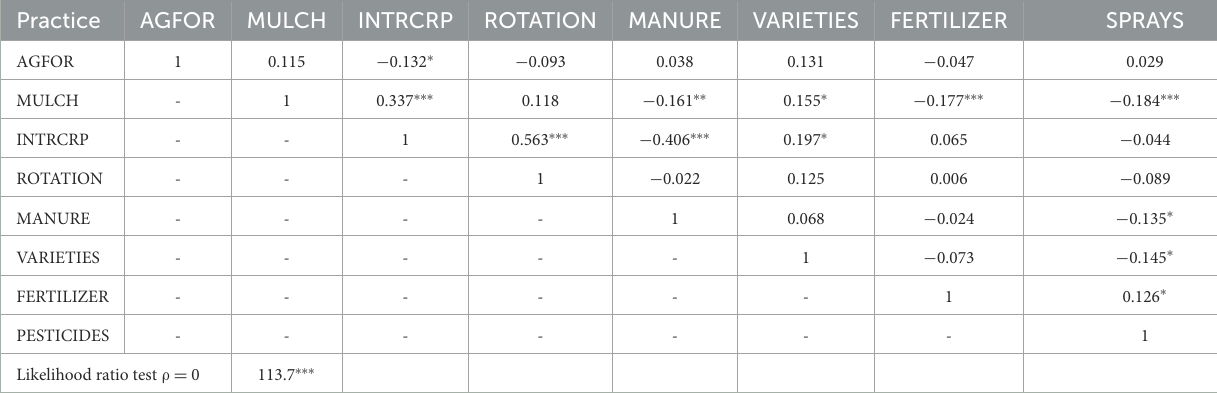
TABLE 4 Correlation matrix of the multivariate probit model for joint decisions on practice adoption at the Fatick site, Senegal. Practice AGFOR MULCH INTRCRP ROTATION